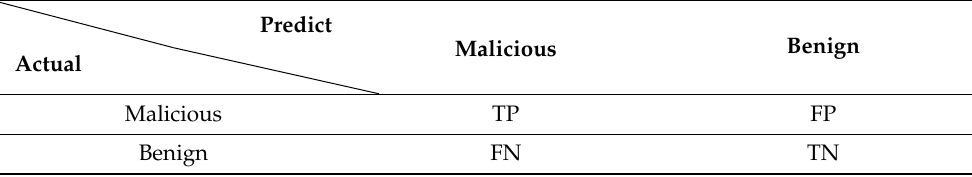
Table 3. Confusion matrix.